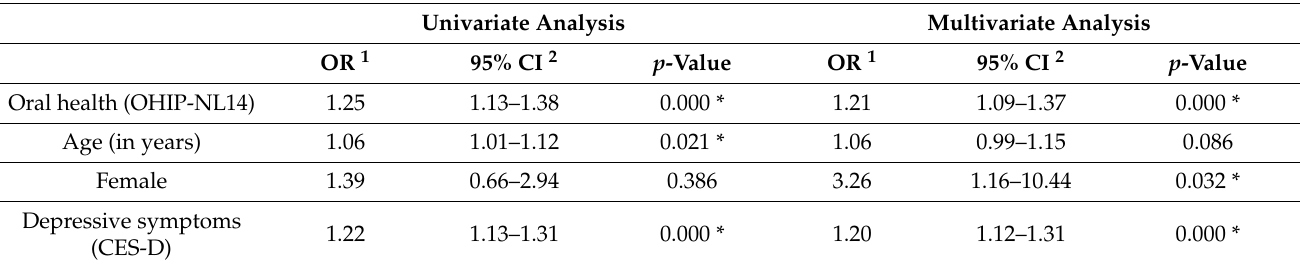
Table 5. Univariate and multivariate logistic analyses after SCAD selection of variables associated with